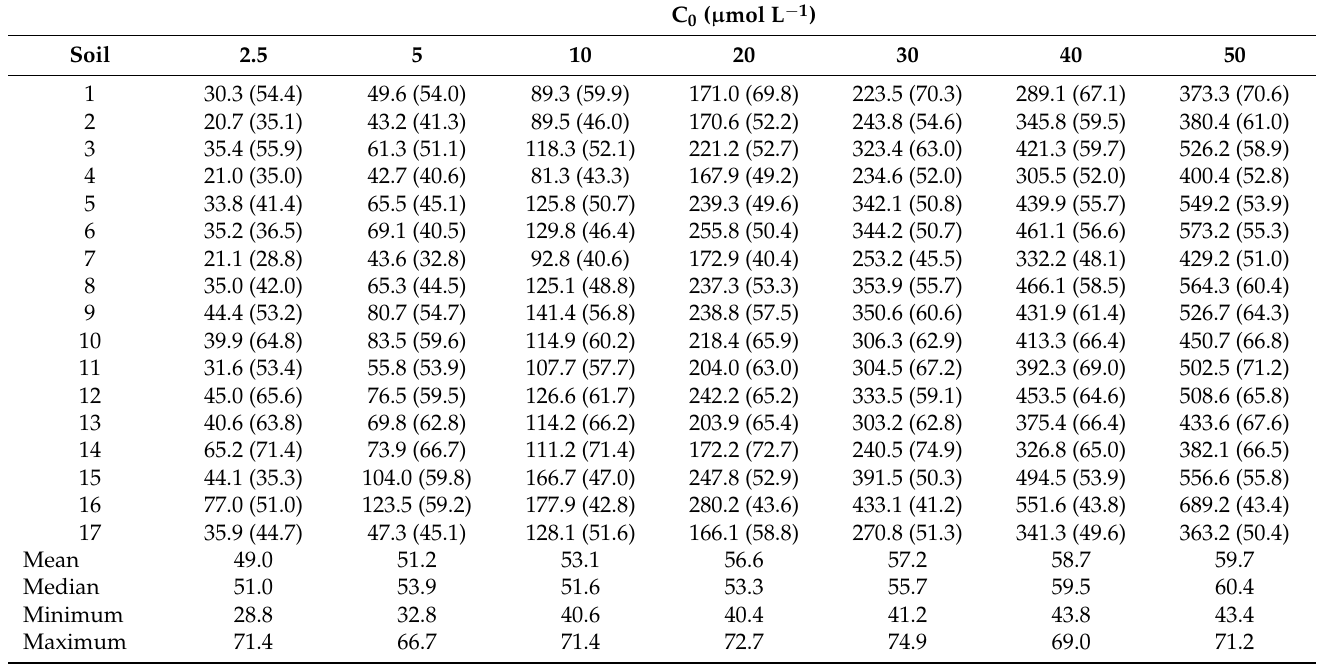
Table 6. Trimethoprim (TRI) desorbed in the equilibrium, expressed in µ mol kg − 1 (and in percentage into brackets) for each of the initial concentrations added (C 0 ) and for each of the 17 soils studied. Mean, median, maximum and minimum refer to desorption